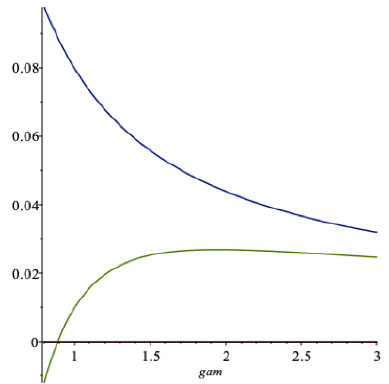
Figure 4. k ( γ ) and ce ( γ ) as functions of γ ; δ =